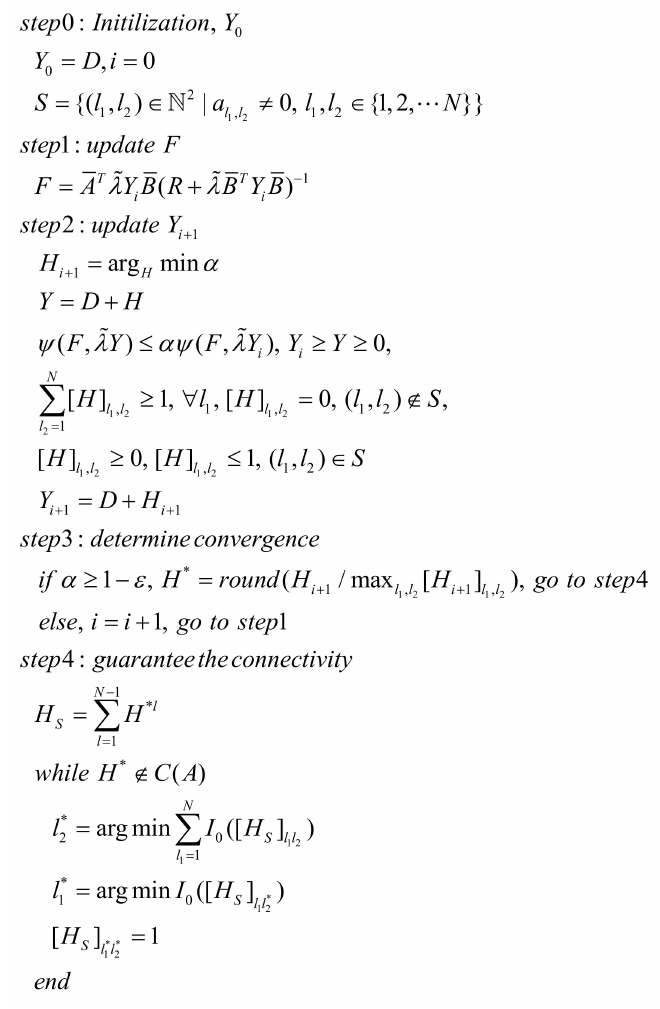
Figure 1. A quantized terminal cost matrix optimization